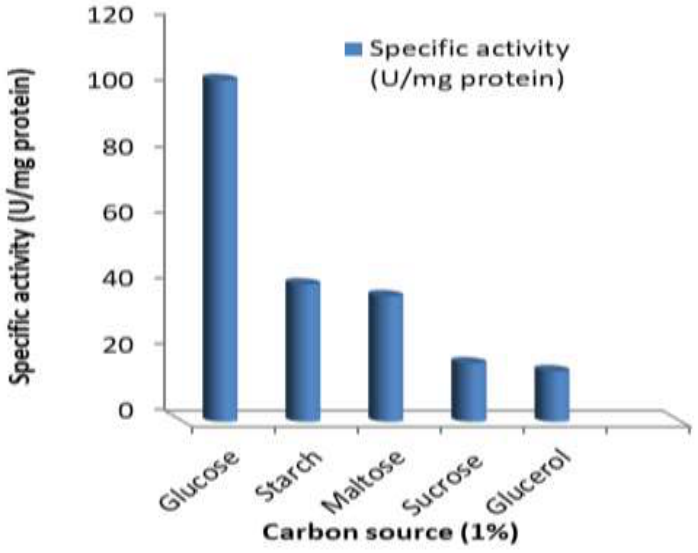
Figure 1: The optimum carbon source for production.